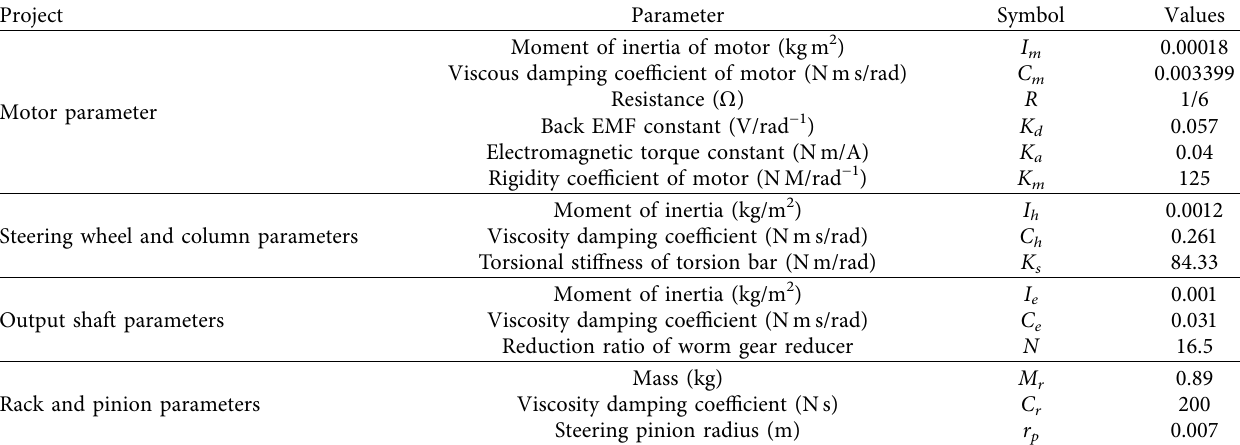
Table 1: Engineering parameters of EPS system